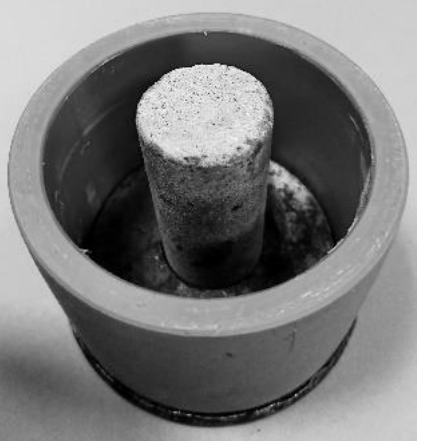
Figure 3. Core sample ready to be filled with cement slurry.